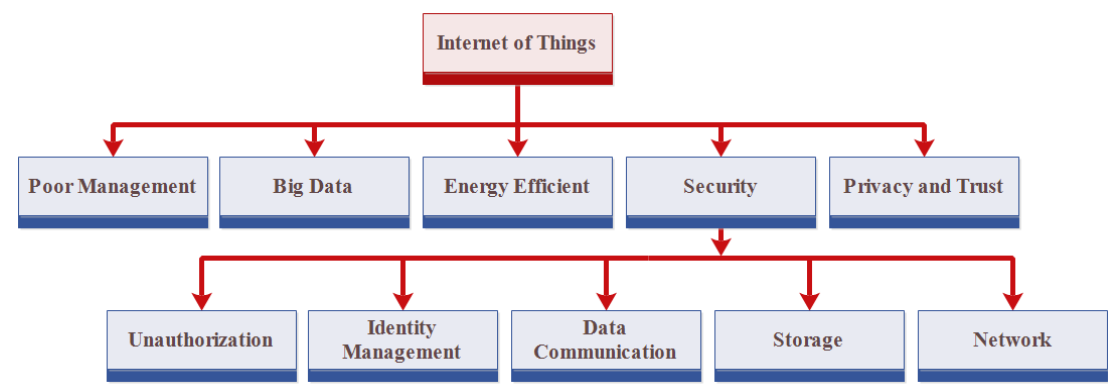
Figure 18. Research challenges and future directions in